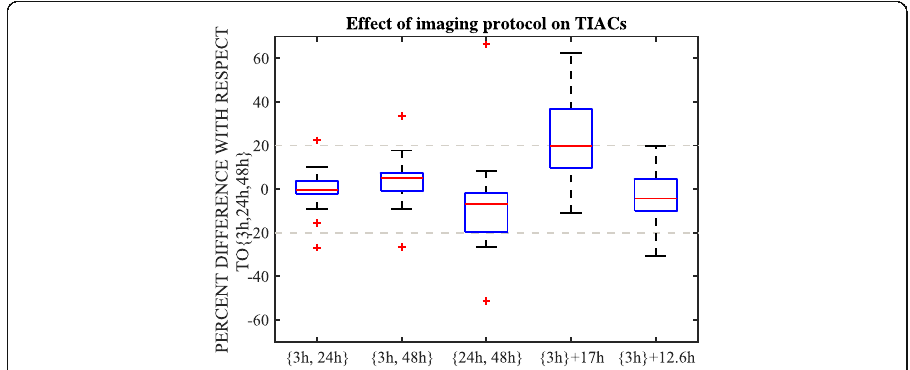
Fig. 5 Distribution of the percent difference of the time-integrated activity coefficients determined using imaging data at {3 h, 24 h}, {3 h, 48 h}, {24 h, 48 h}, {3 h} + physical half-life (i.e., 17 h), and {3 h} + effective half-life (i.e., 12.6 h) with respect to those at {3 h, 24 h, 48 h} (reference dataset). The time-integrated activity coefficients presented in this figure correspond to the tumor, liver, and lungs